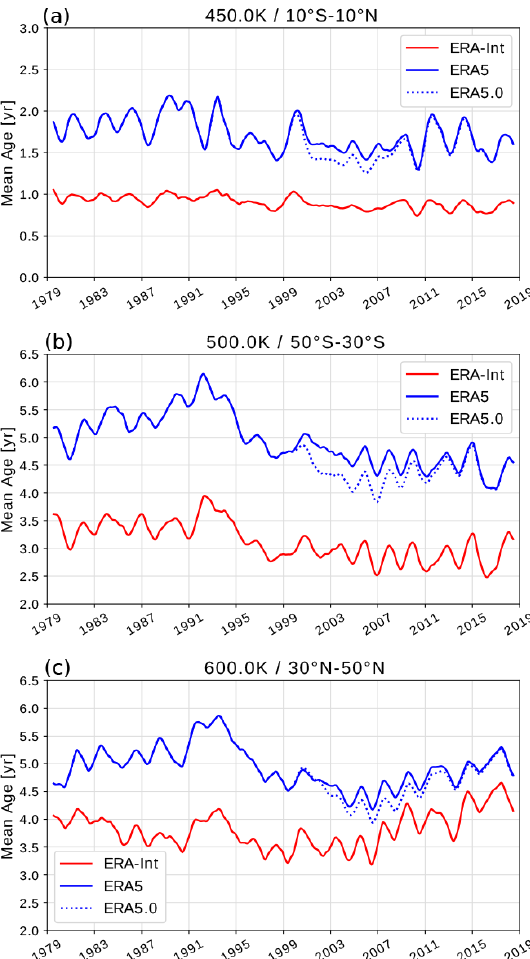
Figure 9. Mean age time series from ERA5 and ERA-Interim in the (a) tropics at 450K and 10 ◦ S–10 ◦ N, in the (b) SH subtropics at 500K and 30–50 ◦ S, and in the (c) SH subtropics at 600K and 30–50 ◦ N. The blue dotted line shows mean age from the sensitiv- ity model simulation driven by the uncorrected ERA5.0 data (see text). Data have been deseasonalized by applying a 12-month run- ning mean.